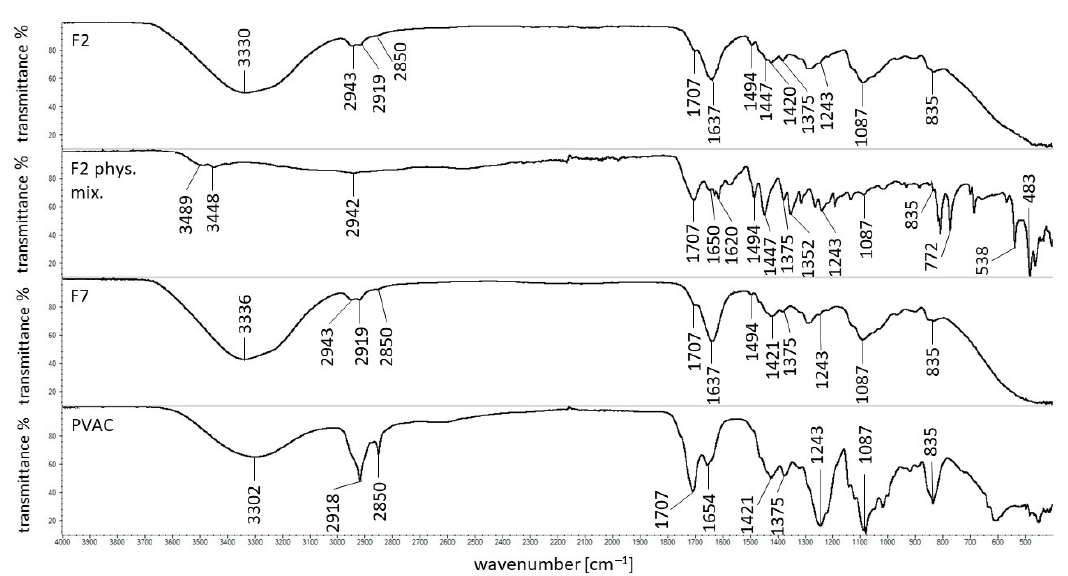
Figure 7. FTIR spectra of formulation F2, its physical mixture, F7, and PVAC-D. The new band observed at 1637 cm − 1 may also be connected with the interaction between the coating and the synthetic polymers. The band of pure PA at 1697 cm − 1 was not found in the spectra of uncoated beads nor in the spectra of coated beads, indicating the possibility of the interaction of PA with APN as well as with PVAC-D. This observation was consistent with the results obtained in the stability study (Figure 3) and may explain the different behavior of formulation doped with PA in comparison to the rest formulations. coated F7 doped with pectinase was coated F7 doped with PA.